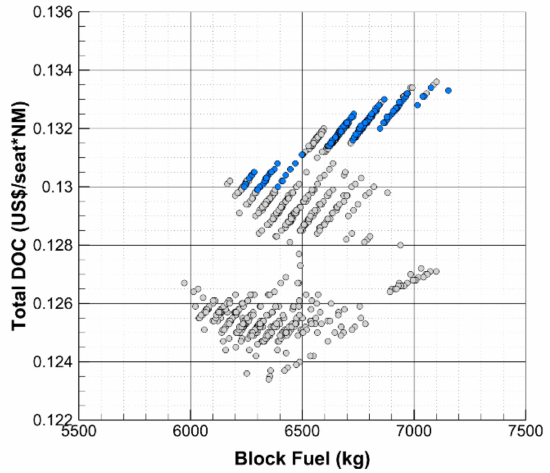
Figure 10. Total DOC versus block fuel for the wing-mounted engines configuration. Blue circles represent the solutions compliant with the imposed set of